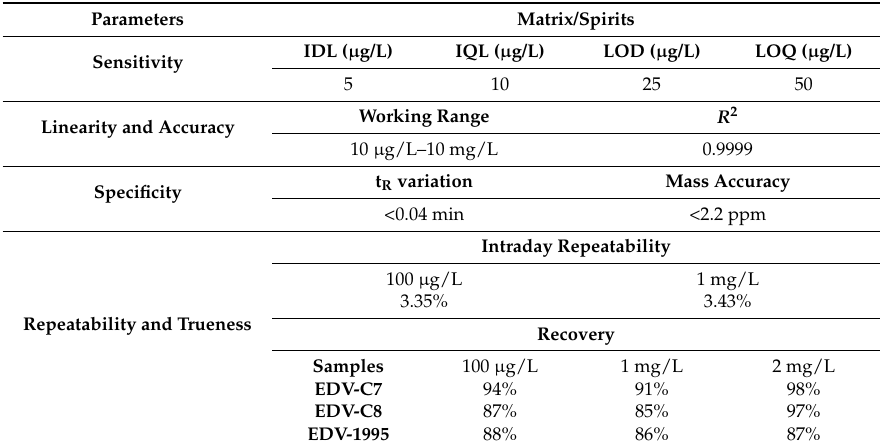
Table 1. Validation parameters for HRMS quantitation of ( ± )-lyoniresinol in